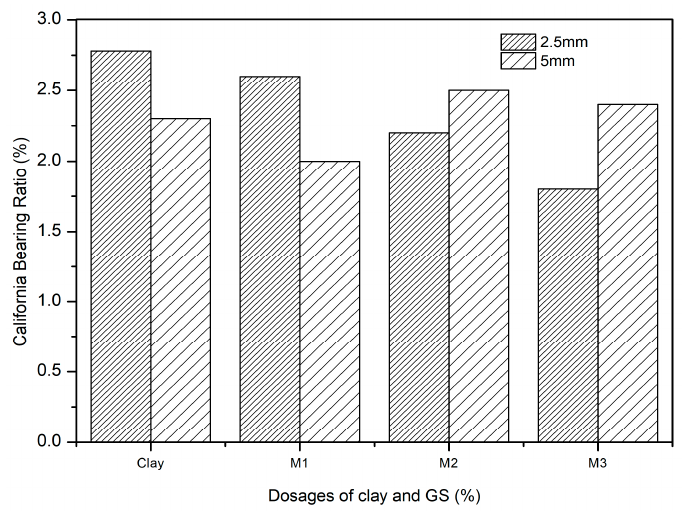
Figure 3. Variation in unsoaked CBR in the presence of GS.